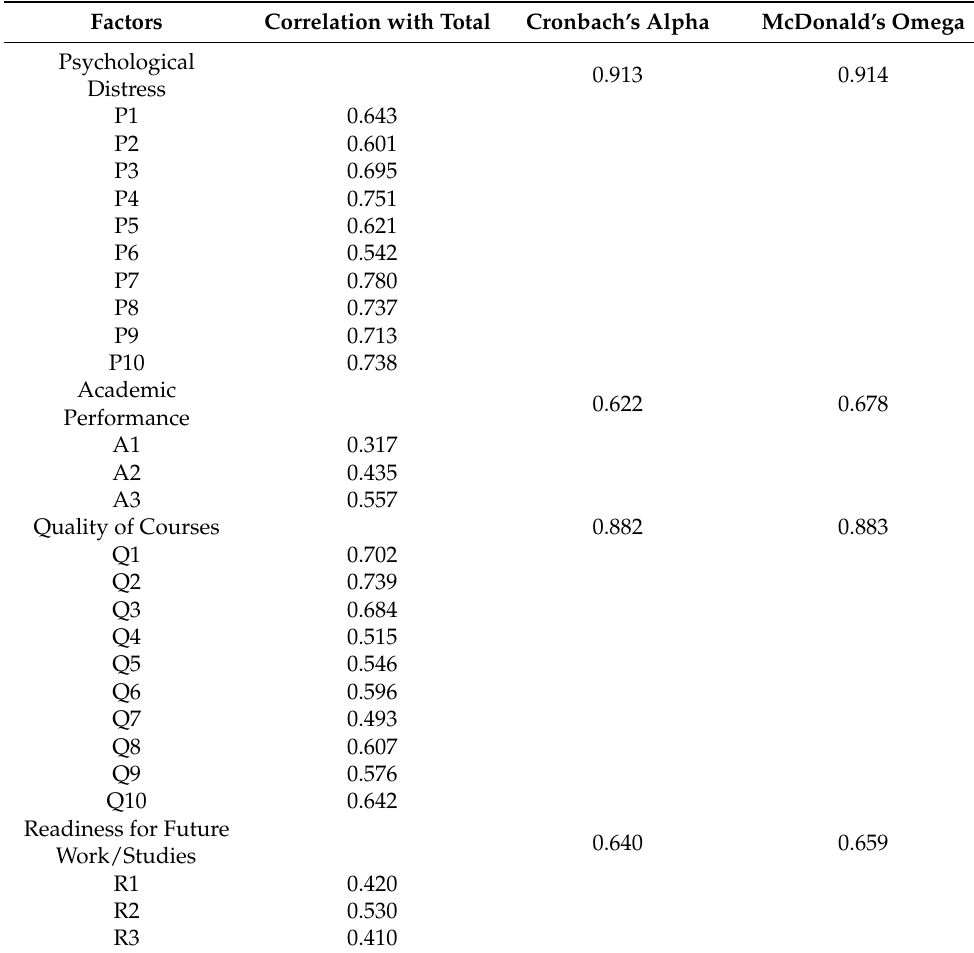
Table 3. Construct